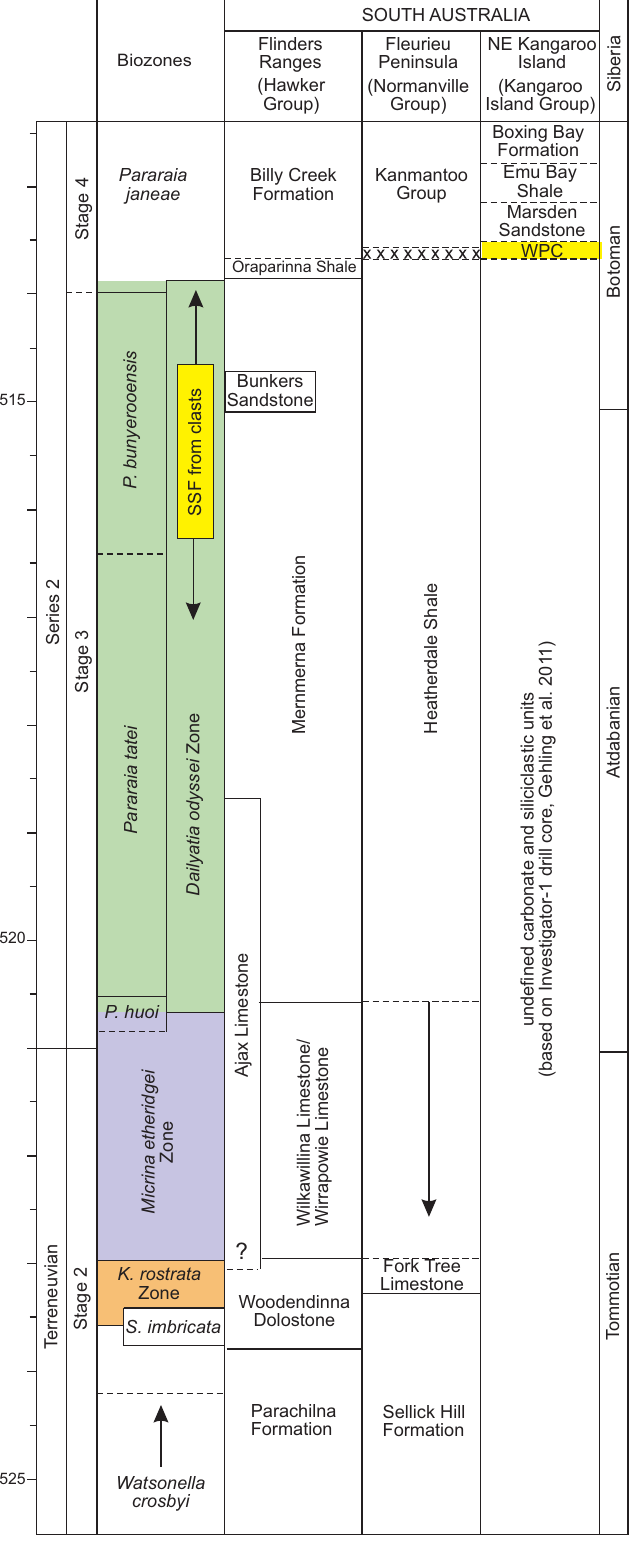
Fig. 2. Correlation chart showing shelly fossil biozones against the strati graphic succession in the Flinders Ranges, Fleurieu Peninsula, and Kangaroo Island (adapted from Betts et al. 2018: fig. 27). Note: The succession in the NE Kangaroo Island is based on the Investigator-1 drill core in which the Mt. McDonnell Formation is not apparent (Gehling et al. 2011). Lower boundary of White Point Conglomerate (WPC) is likely faulted. Abundant and diverse shelly fauna (SSF) from the bioclastic limestone clasts in the WPC have an upper Dailyatia odyssei Zone age. Dashed lines indicate uncertain stratigraphic relationship. Abbreviations: K ., Kulparina ; P ., Parabadiella ; S ., Sunnaginia